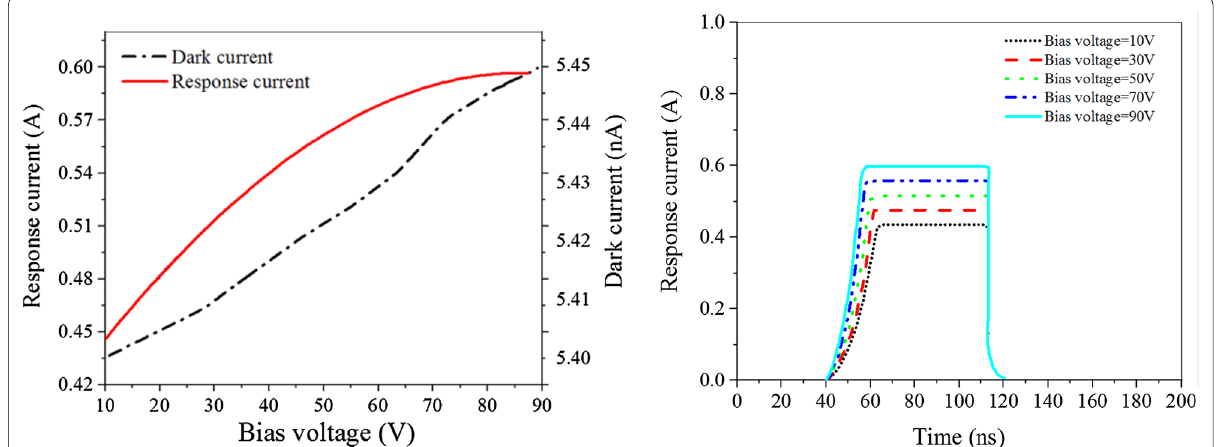
Fig. 3 The response current, dark current characteristic and rising time change curve of photodetector at different reversed bias voltage